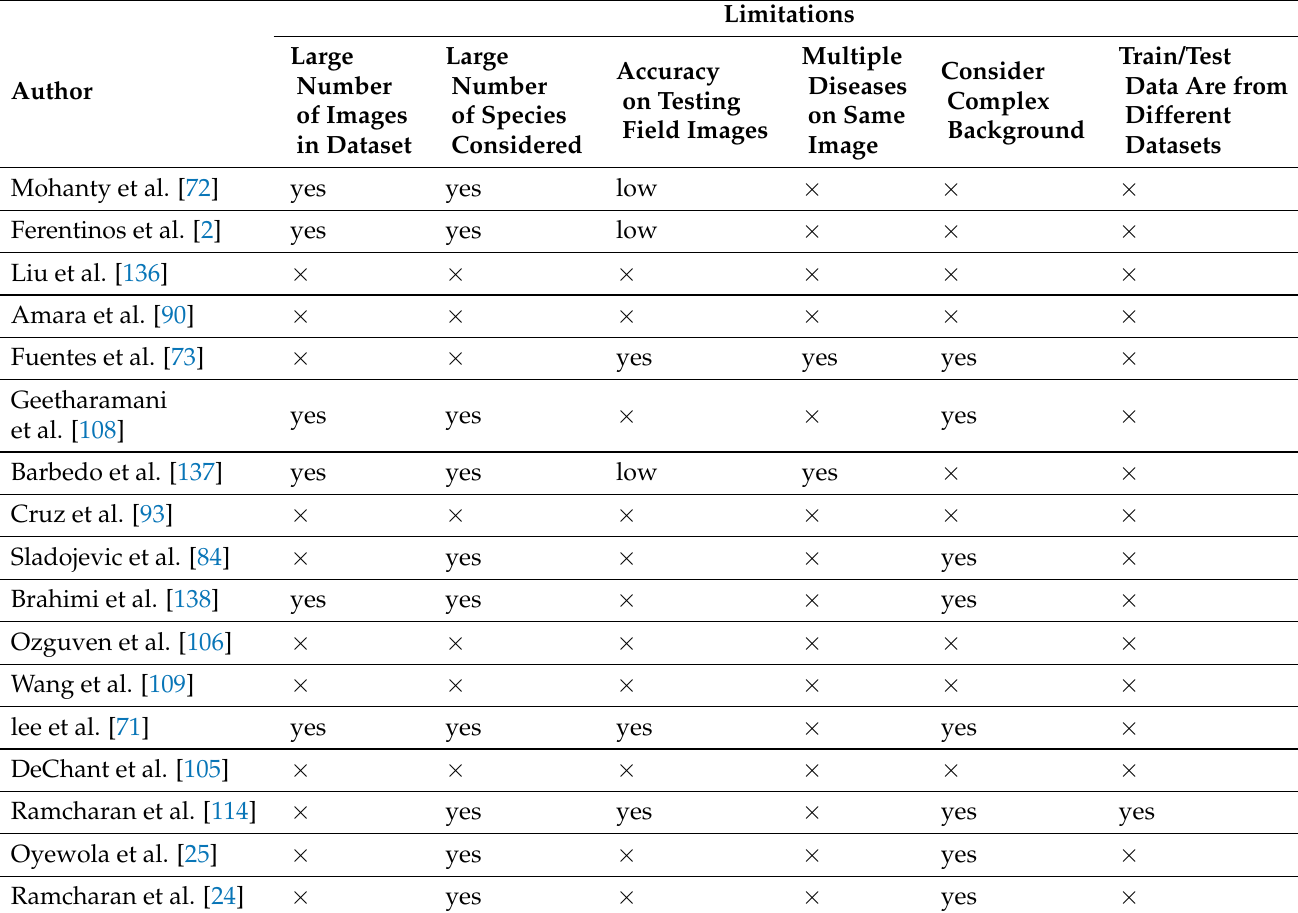
Table 6. Limitation of deep learning models for the identification of plant